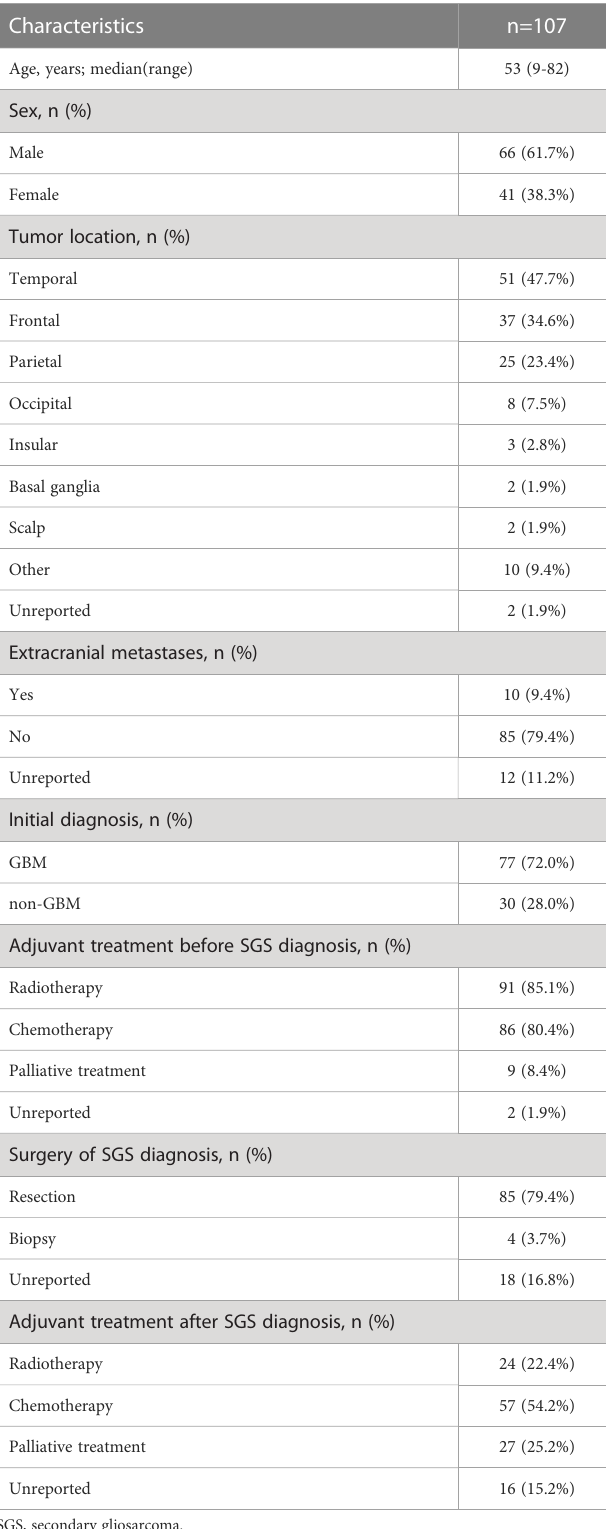
TABLE 2 Demographic data for all